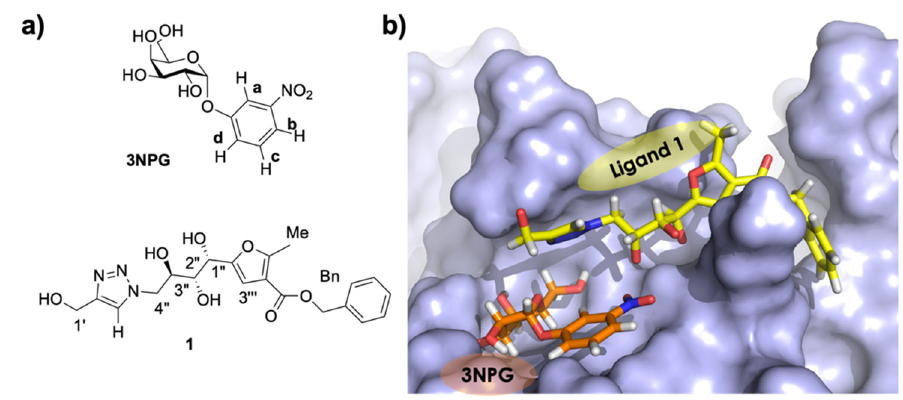
Figure 4. ( a ) Chemical structure and nomenclature of the CTB ligands 3NPG and 1 . ( b ) 3D model of the 3NPG/CTB/ 1 ternary